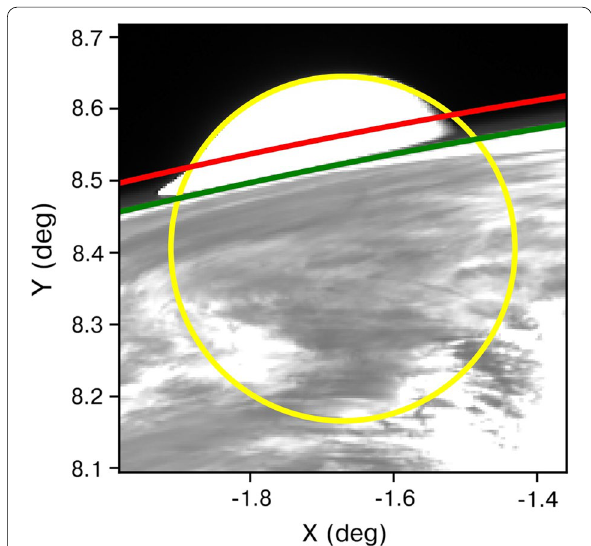
Fig. 13 The lunar image of 2017/09/10 05:40 at band 14 with the lunar rim bent by the terrestrial atmosphere. The yellow circle is the lunar rim determined by fitting a circle. The green line is the Earth’s rim. The red line is the rim of the eliminated area from the following analysis, that is, a circle with a radius of 100.45% of the Earth. The lunar pixels between the red and green lines are refracted by the terrestrial